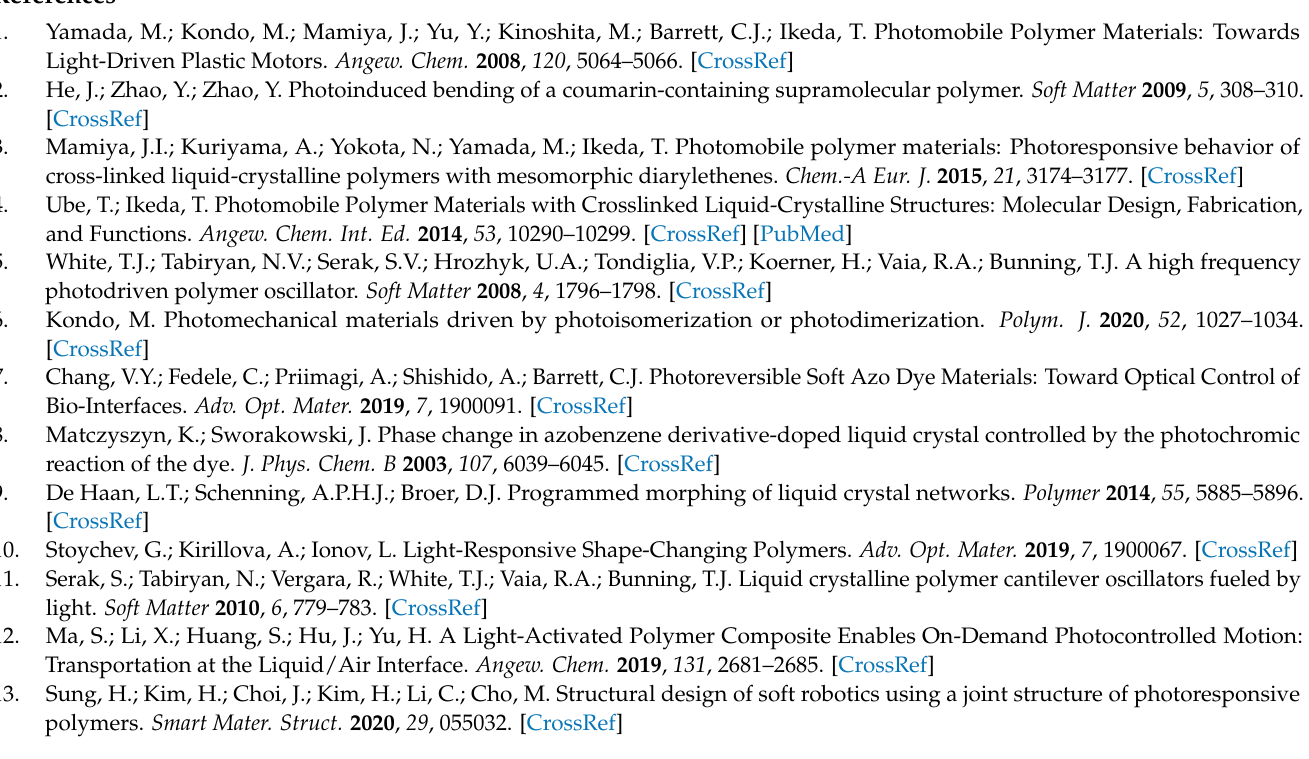
structure. Figure S3: (A) Absorbance of the azobenzene moieties embedded in the PMP, obtained by subtracting the contribution of the other elements in the PMP (B) Absorbance of azobenzene moieties in trans post irradiation, obtained subtracting the absorbance of the PMP pre-UV. Figure S4: Setup for characterization of PMPs light response. Figure S5: X-ray diffraction patterns (Cu K α ) of the starting monomer powders. Figure S6: Picture of melted monomer penetrated in the cell (left) and outside the cell(right). In both the pictures it is possible to see trails formed by the interaction of nanoparticles and LCs. Objective 10 × . Figure S7. Aggregates and trails formed by nanoparticles. On the left a closeup picture (100 × ) of a cell-like structure in a Azo-LC-PMP(6%-Z) and on the right a Azo-LC- PMP (1%-ZnO) mixture showing the aggregates and trails (10 × ). Figure S8: 3D-topography AFM image of ZnO-doped PMP film detected by scanning 5 × 5 µ m 2 -sized area. Figure S9: Topography AFM images of ZnO-doped PMP film detected by scanning 2 × 2 µ m 2 (A) and 10 × 10 µ m 2 (B) -sized areas. Figure S10: DSC Thermograms of Azo-LC-PMP and ZnO composite scans. Figure S11: (left) Self-Oscillating Azo-LC-PMP without ZnO nanoparticles (right) Bending speed (m/s) of Azo-LC- PMP Z polymerized at 50 ◦ C and 60 ◦ C. Showing the improved performance of the film when polymerized at the nematic